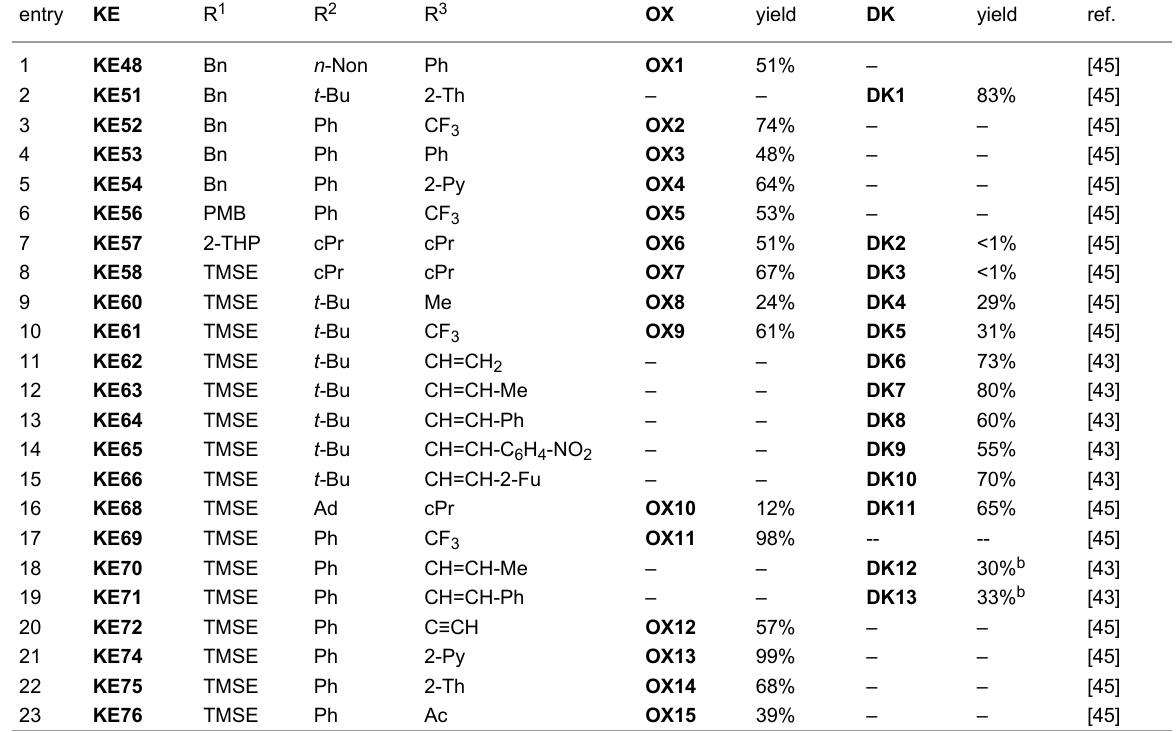
a Abbreviations: Ad = 1-adamantyl, Py = pyridyl, Fu = furyl, Th = thienyl, Ac = acetyl; all alkenyl substituents are E -configured. b In addition, ca. 30% of a dimeric compound were